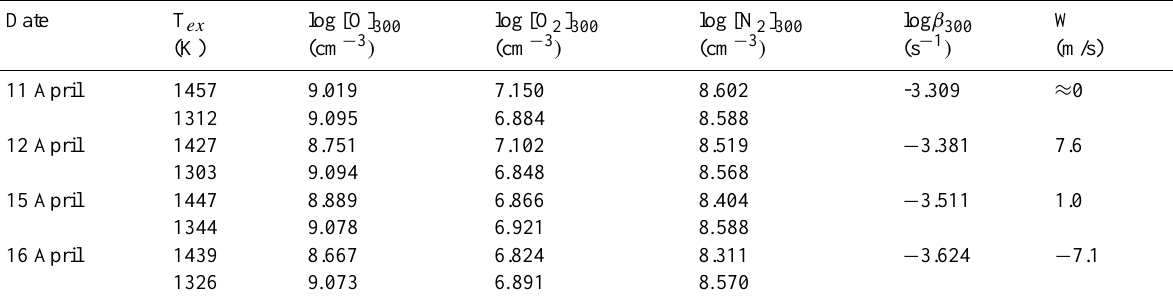
Table 3. Aeronomic parameters at 300km for the 11/12 April 2000 and 15/16 April 2002 periods. Second line shows the NRLMSISE-00 model